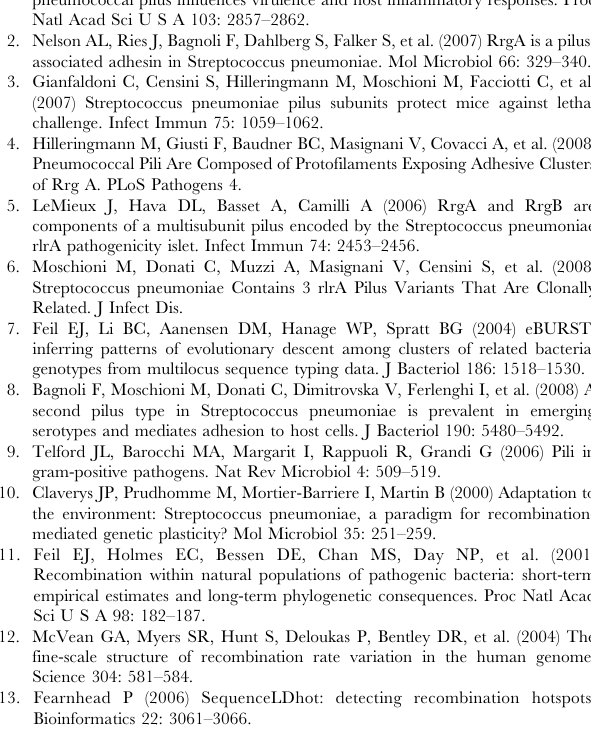
Table S1 Name, capsular serotype, MLST Sequence Type, eBURST Clonal Complex, and country of isolation of the strains used for this study.